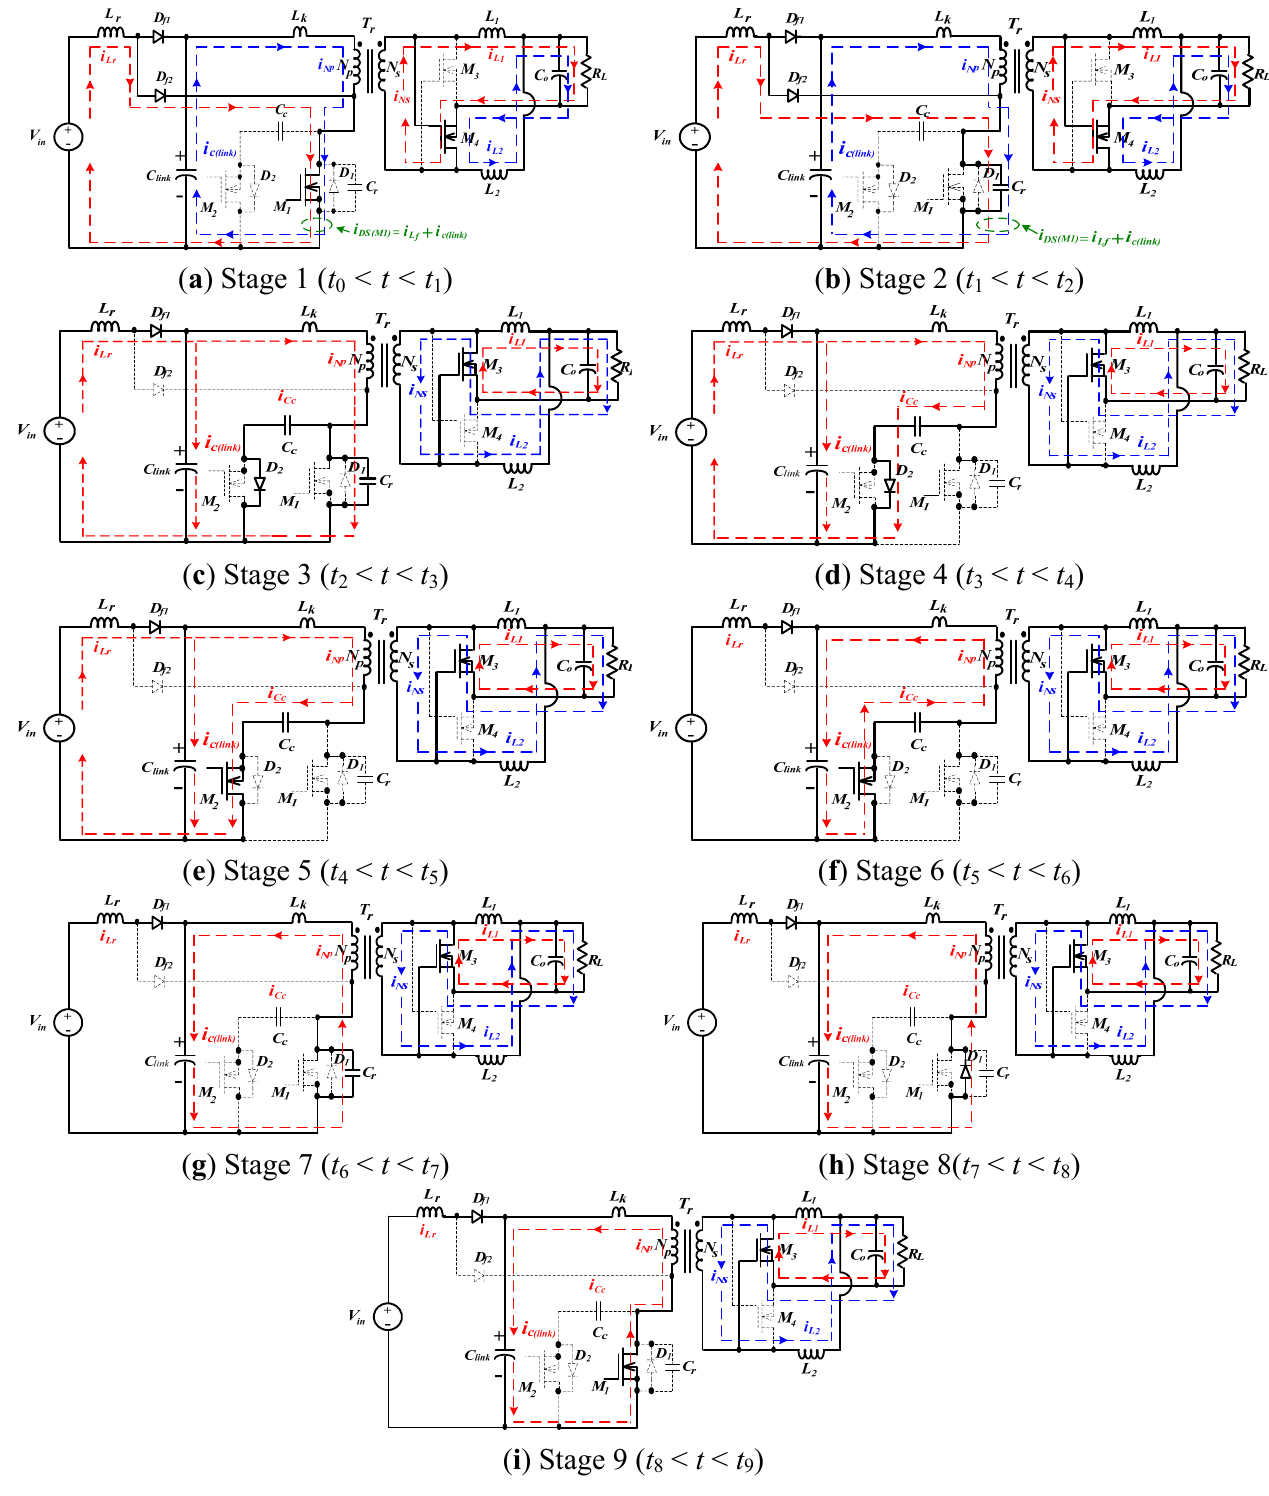
Figure 7. Equivalent circuits of operating stages for the proposed power supply